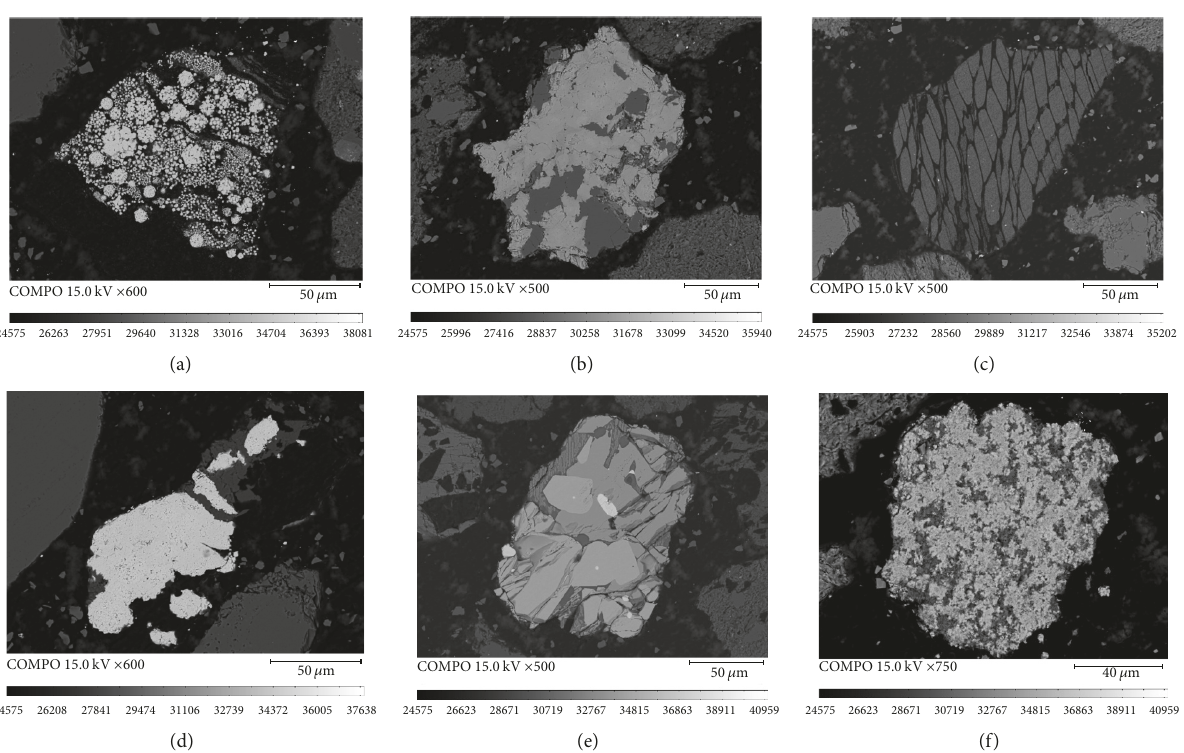
Figure 7: Backscatter imagery of different mineral in heavy product: (a) pyrite; (b) quartz; (c) kaolinite; (d) iron oxide; (e) chalcopyrite; (f)